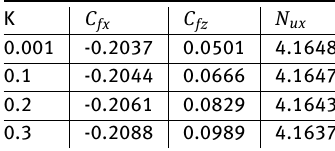
Table 4: Variation of quantities of interest with Grashof number m = 0.3000 , χ = 0.2500 , Gr = 3.00 , and β = 0.1 Pr K C fx C fz N ux Pr K C fx C fz N ux 2 0.001 -0.1388 0.1192 2 0.1 4 0.001 8 0.001 Pr K